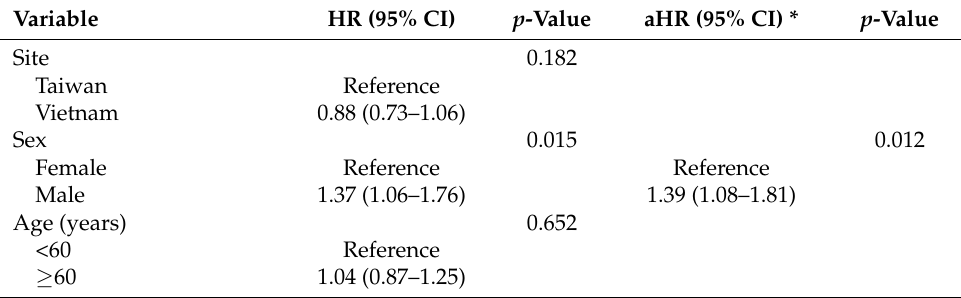
Table 4. Risk for HCC patients receiving hepatic